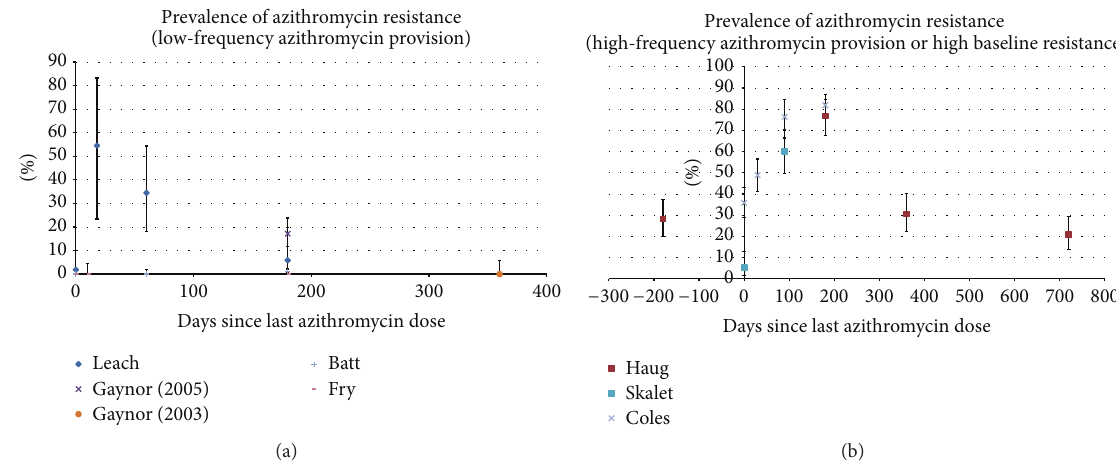
Figure 2: (a) Prevalence of azithromycin resistance amongst pneumococcus carriers plotted against time in studies with low-frequency azithromycin provision. The error bars show 95% confidence intervals about the proportions. (b) Prevalence of azithromycin resistance amongst pneumococcus carriers plotted against time in studies with high-frequency azithromycin provision or high baseline resistance. The error bars show 95% confidence intervals about the proportions.